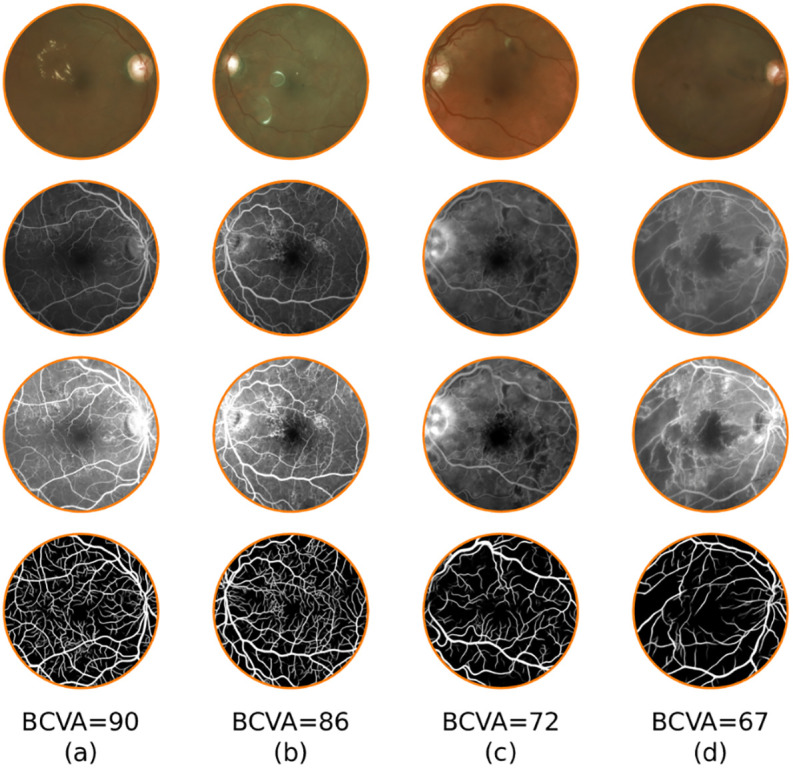
Example images across the range of best corrected visual acuity (BCVA) seen in the study demonstrating differences in vessel density.From top to bottom: fundus image, original UWFFA, contrast-enhanced UWFFA views, and detected vessel maps for four patients over circular regions centered at the fovea. Example images in columns (a) and (b) have better BCVA and higher vessel densities, while those in columns (c) and (d) have worse BCVA and lower vessel densities.